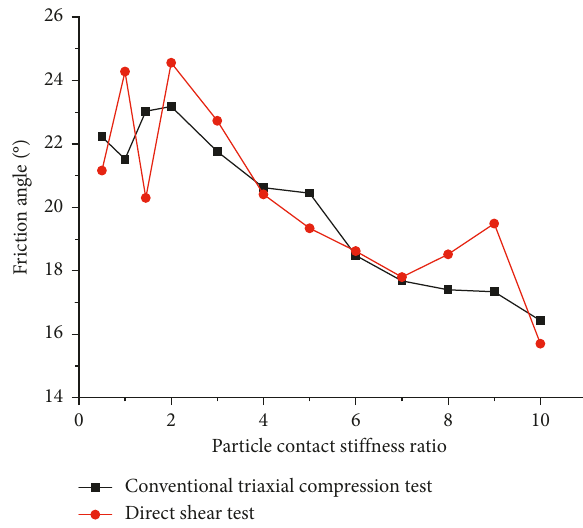
Figure 1: Influence of particle contact stiffness on friction